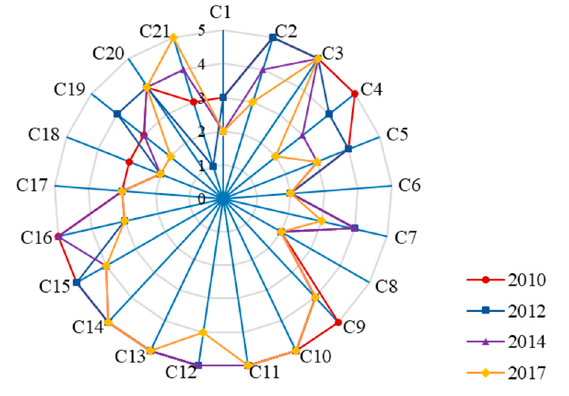
Figure 5. Radar map of the indicator change trends in 2010, 2012, 2014, and 2017.